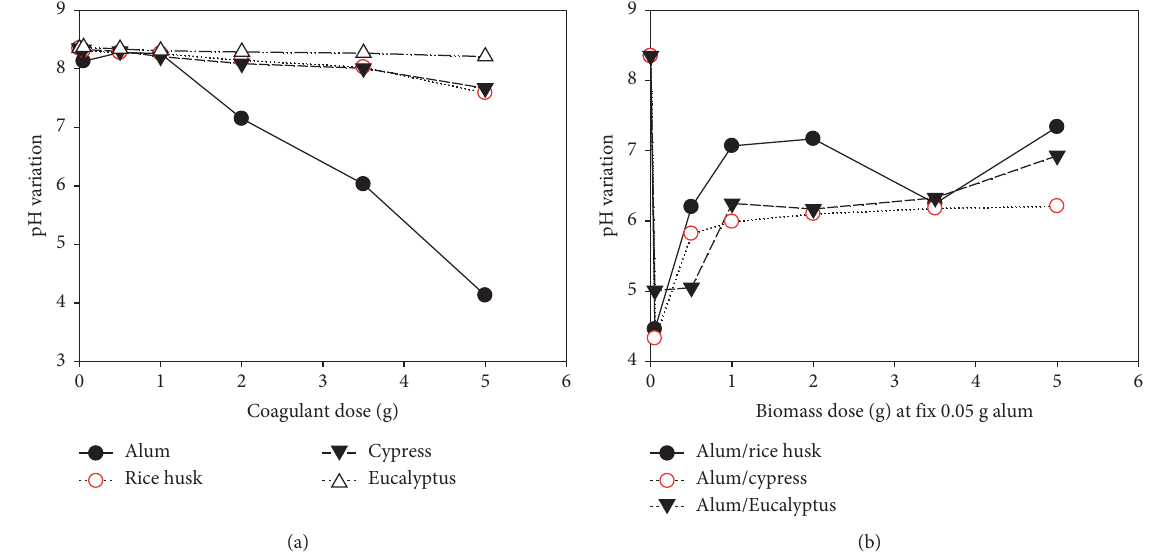
Figure 8: Variation of pH in MSW with (a) individual and (b) mixed coagulants.